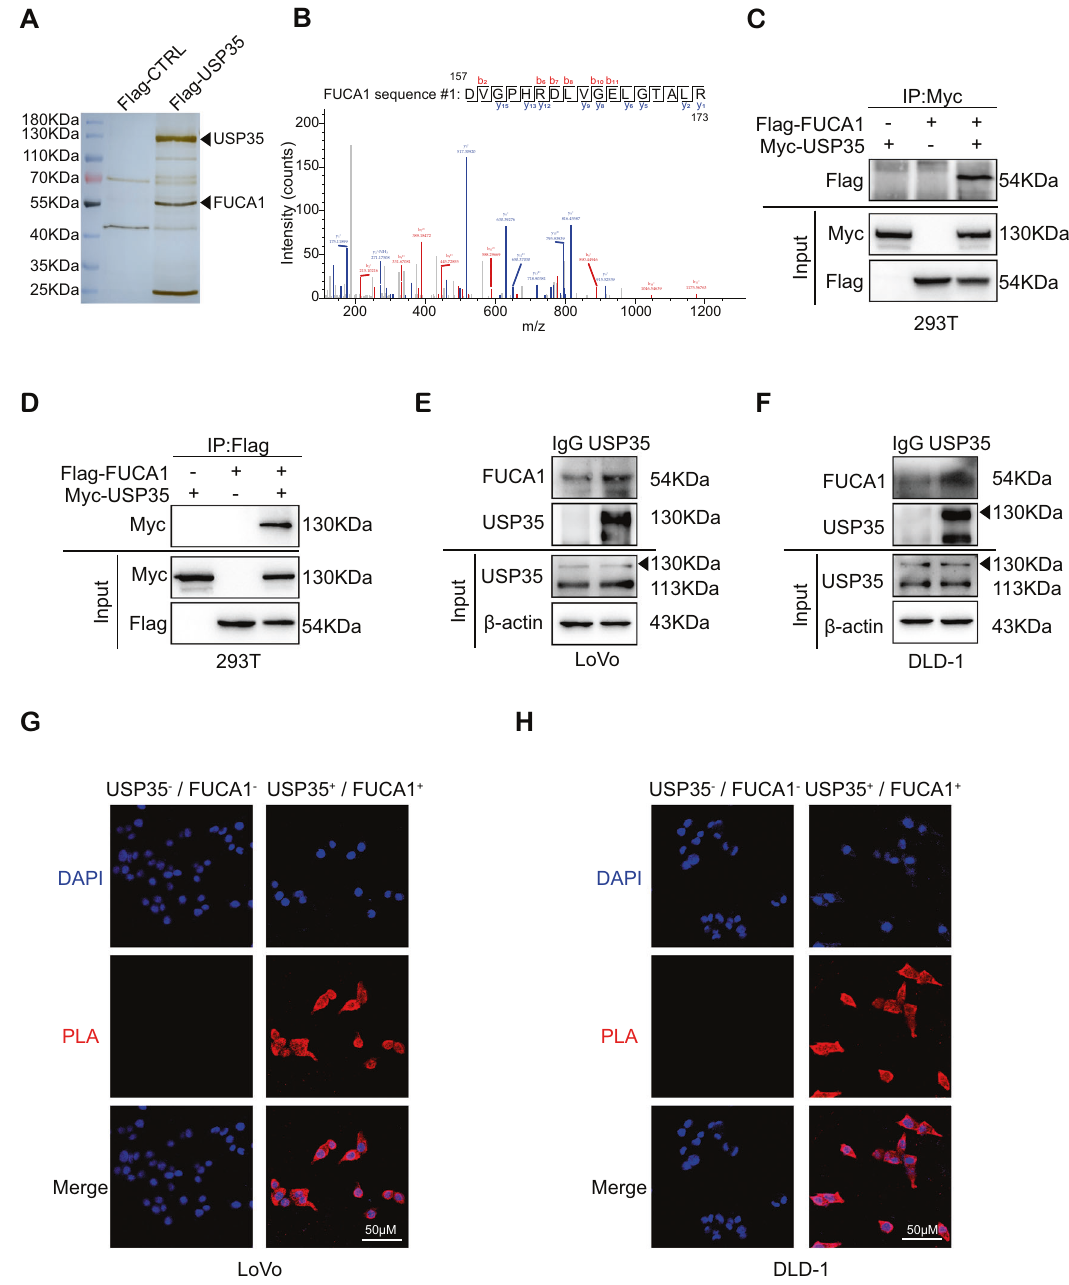
Fig. 3 USP35 interacts with FUCA1. A Silver staining of the SDS-PAGE gel containing anti-Flag antibody immunoprecipitated proteins in Flag- USP35-overexpressed HCT116 cells and the control cells. B Representative map of mass spectrometry peaks of FUCA1 interacting with Flag- USP35. C , D Exogenous interaction between USP35 and FUCA1. HEK293T cells were co-transfected with Flag-FUCA1 and/or Myc-USP35 plasmids. Cell lysates were immunoprecipitated with indicated antibodies, followed by immunoblotting with anti-Flag antibody ( C ) or anti- Myc antibody ( D ). E , F Endogenous interaction between USP35 and FUCA1. Cell lysates from LoVo ( E ) and DLD-1 ( F ) were immunoprecipitated with anti-USP35 antibody or IgG antibody, followed by immunoblotting with anti-FUCA1 antibody. G , H Proximity ligation assay (PLA) showing USP35 and FUCA1 interaction in LoVo ( G ) and DLD-1 ( H ) cells. The results were the representative of three independent levels of FUCA1 in the presence of MG132. As a result, forced (Fig. 4C, D). Resultantly, enhanced USP35 expression increased FUCA1 expression of USP35 in LoVo and HT29 cells failed to “ wax ” FUCA1, at protein levels in CRC cells and HEK293T in a dose dependent and depletion of USP35 in DLD-1 and HCT116 cells failed to “ wane ” manner (Fig. S6A, B), while dampened USP35 expression clearly FUCA1 as it usually did with addition of MG132 (Fig. 4E, F), indicating decreased the protein levels of FUCA1 in DLD-1 and HCT116 cells (Fig. USP35 protected FUCA1 from proteasome-mediated degradation. S6C). As expected, USP35 overexpression or silencing did not affect Overall, these results demonstrate that USP35 deubiquitinates FUCA1 the mRNA levels of FUCA1 (Fig. S6D, E). Since proteasome is required and increases FUCA1 stability by preventing ubiquitin-proteasome in the ubiquitin-proteasome pathway for protein degradation, we pathway-mediated degradation of FUCA1. further tested how altered expression of USP35 would affect the